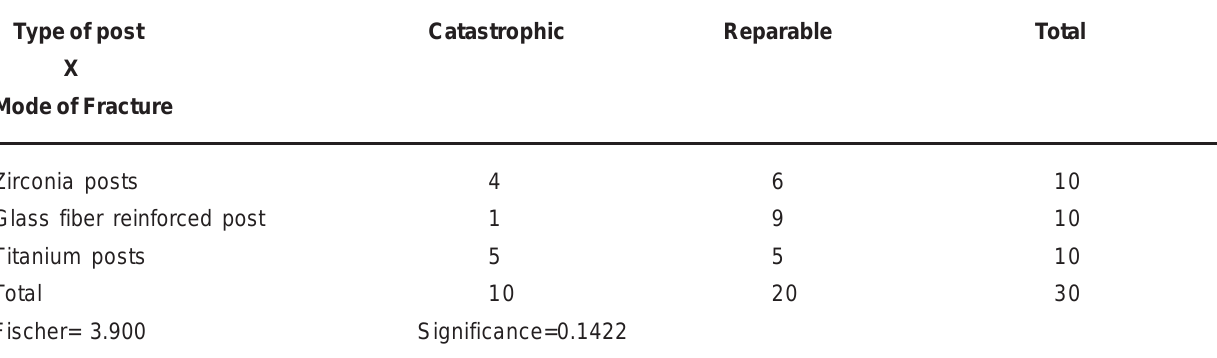
*One-Way ANOVA showed no statistical difference among groups (P=0.08)